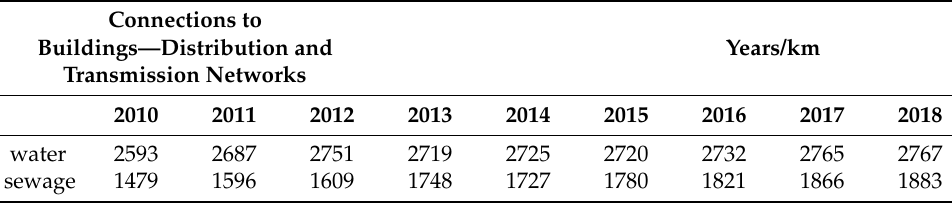
Table 6. Length of industrial networks in rural communes in the Trnava region from 2010 to 2018. Connections to